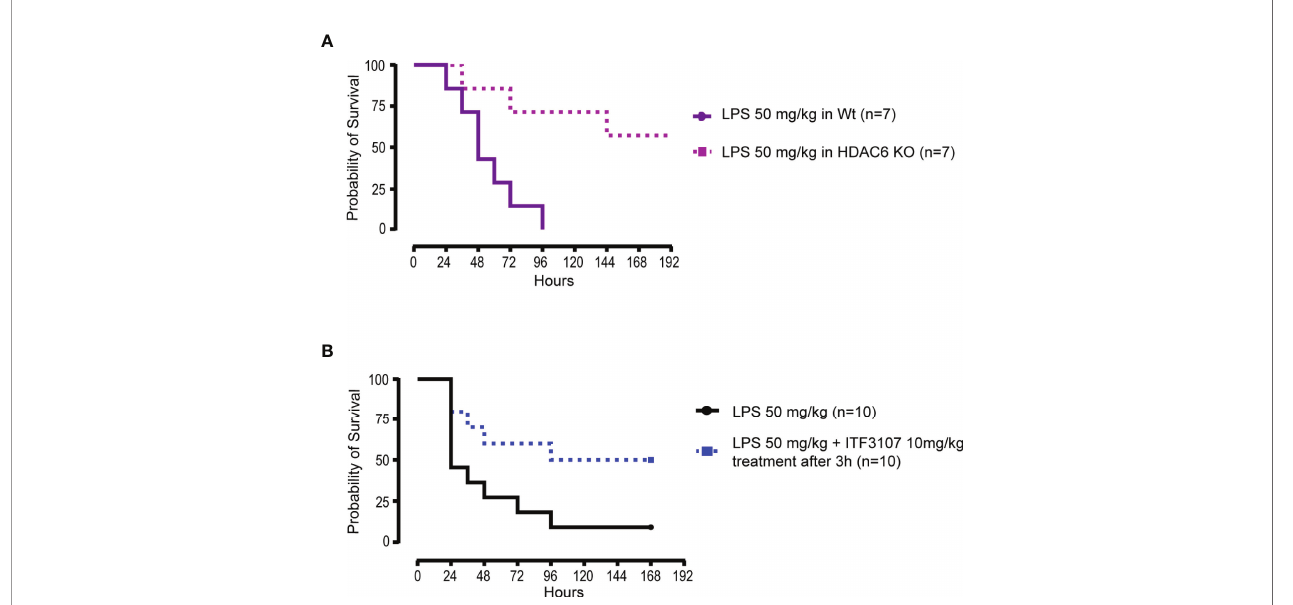
FIGURE 3 | HDACi reduce mortality in mice subjected to LPS-induced septic shock in vivo . (A) C57BL/6 wildtype (WT) mice and C57BL/6 HDAC6 KnockOut (HDAC6 KO) mice were challenged with lethal dose of E.Coli LPS 50 mg/kg intraperitoneal (ip). The experiment was conducted for a maximum of 10 days and 7 mice for group were analyzed. The graph represents the survival curve of WT and HDAC6 KO mice treated with LPS. (B) C57BL/6 WT mice were challenged with lethal dose of E.Coli LPS 50 mg/kg ip. Before 3 hours from the LPS administration, animals were randomized and divided into two groups of 10 mice each. One group was treated with LPS and the other with the combination of LPS and ITF3107 (HDAC6 inhibitor) 10mg/kg. ITF3107 10 mg/kg was administrated once ip 3 hours after LPS treatment. The experimental design planned the animal treatment with HDAC6i with the septic shock already in progress. The experiment was conducted for a maximum of 10 days. The graph represents the survival curve of wild type mice treated with LPS and treated or not treated with